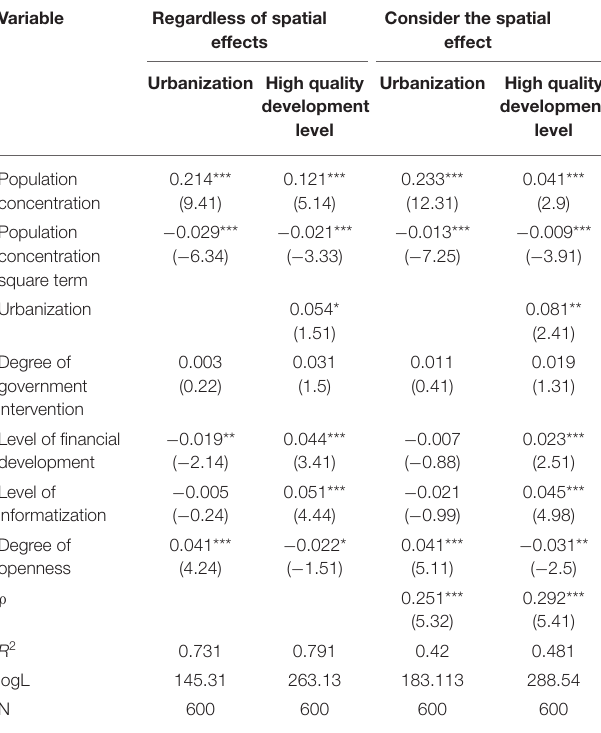
TABLE 6 | Test results of the mediating mechanism of population agglomeration affecting high-quality development.